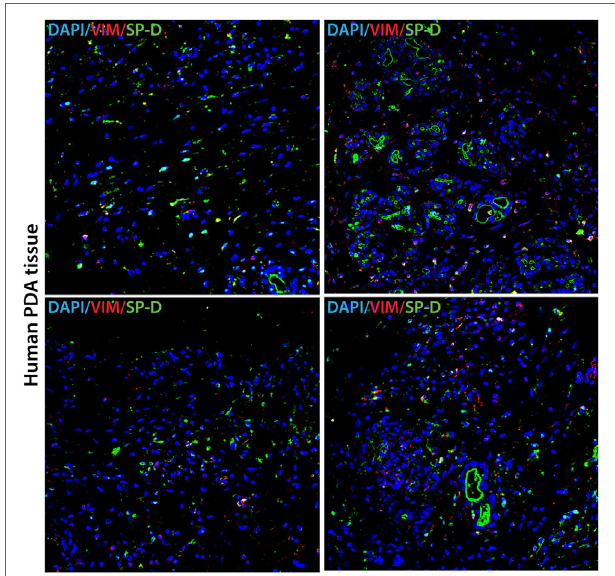
FigUre 1 | Human pancreatic cancer tissue expressing SP-D and Vimentin. Double immunofluorescence staining of SP-D (green), Vimentin (red), and DAPI (blue) in four different areas of representative human pancreatic cancer tissue. Scale bars, 50